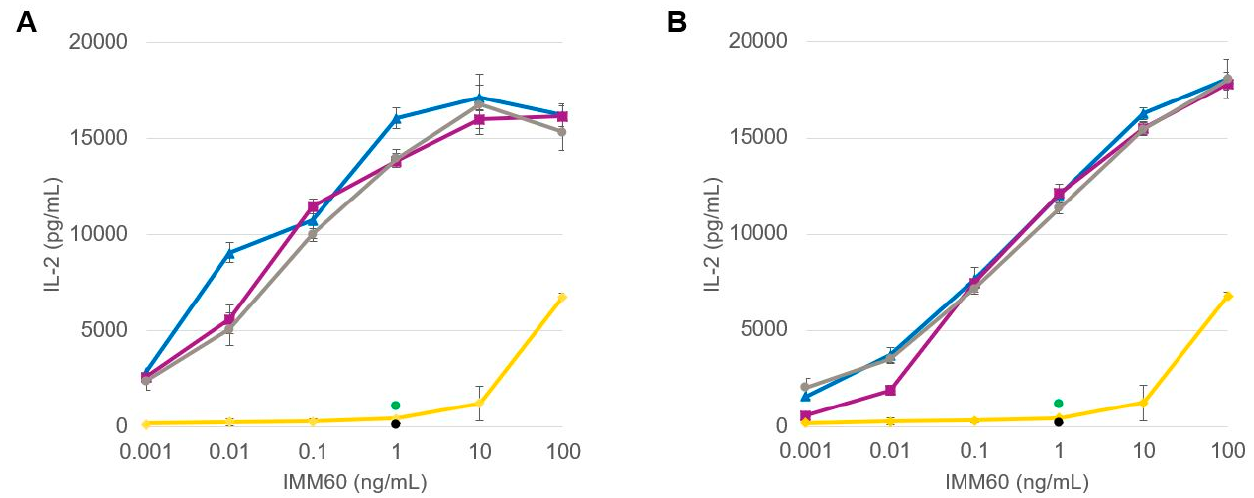
Figure 3. Dose-dependent IL-2 production by DN32.D3 mouse NKT cell hybridoma activated in vitro by PLGA nanovaccine formulations generated at the ( A ) lab scale and ( B ) industrial scale. Data obtained for particles containing peptide 1, peptide 2 and peptide 3 are represented in blue, purple and grey, respectively. Placebo particles, free soluble IMM60 and negative control are depicted in green, yellow and black, respectively.